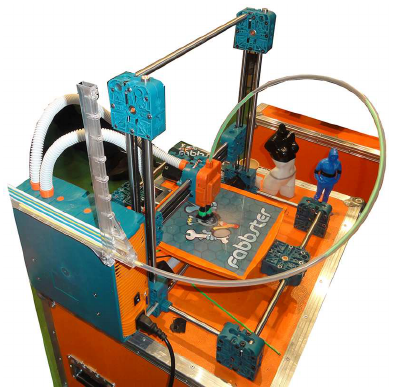
Figure 16. Sample of a 3D printer suited to print, e.g., 3D models of Cultural Heritage objects with maximum size of 225mm x 225mm x 210mm showing ±0.1mm (Fabbster 3D